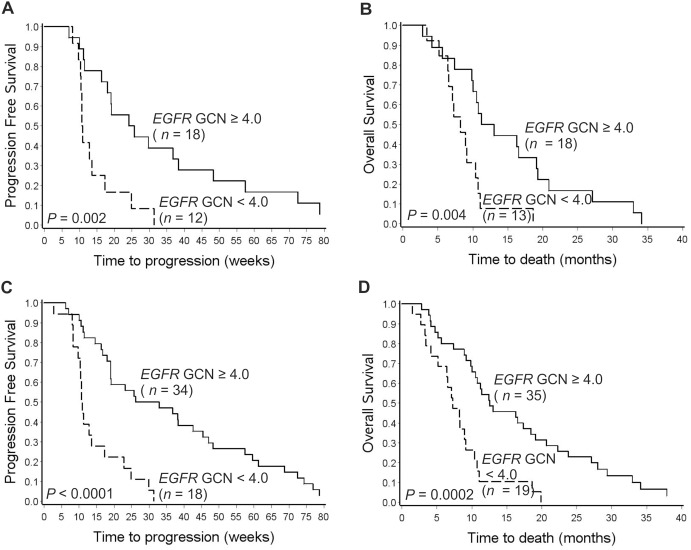
Kaplan Meier survival curves of KRAS wt colorectal cancer patients treated with anti-EGFR therapy.Progression free survival (a) and overall survival (b) of the test validation cohort according to EGFR gene copy number. Progression free survival (c) and overall survival (d) of the combined chemorefractory patient cohort.